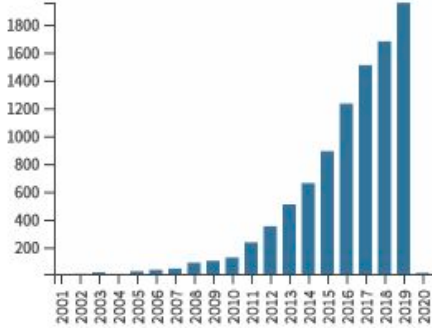
Figure 2. Citations by years and record count.